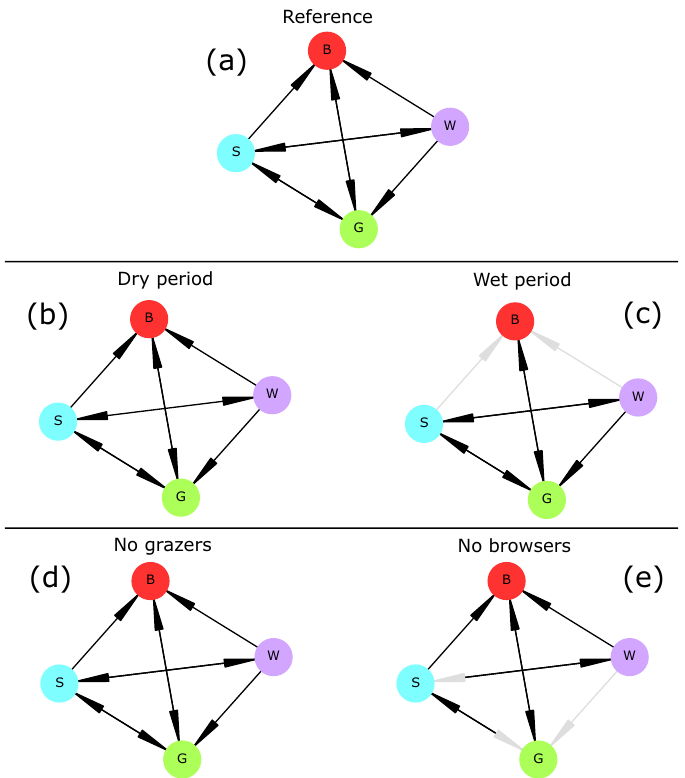
Figure 2. Vegetation transitions for each scenario. Vegetation summary graphs for ( a ) the reference scenario, ( b ) the “dry period”, ( c ) the “wet period”, ( d ) “no grazers”, and ( e ) “no browsers”. Node labels indicate vegetation types as defined in Section 2.6, with B: Bare soil; G: Grassland; S: Savanna, and W: Woodland. Node colors are arbitrary and correspond to vegetation types. Grayed out edges are absent from the graph and highlight differences relative to reference scenario. Grayed out arrow tips (e) indicate when a bidirectional transition becomes